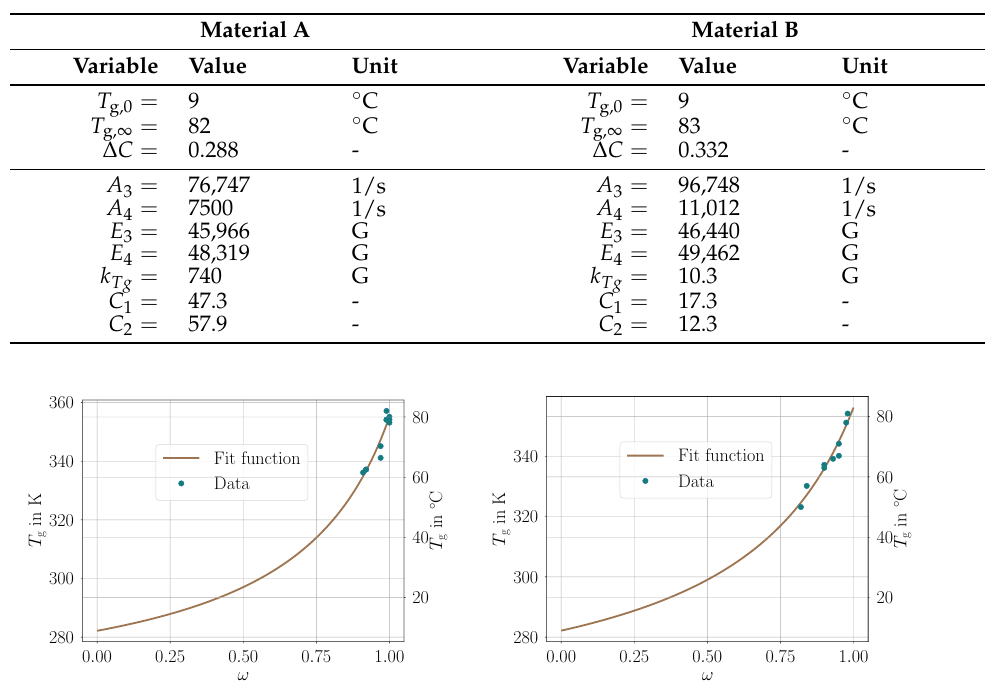
Table 4. Determined measurement procedure and material parameters as a result of the optimization problem for materials A and B.